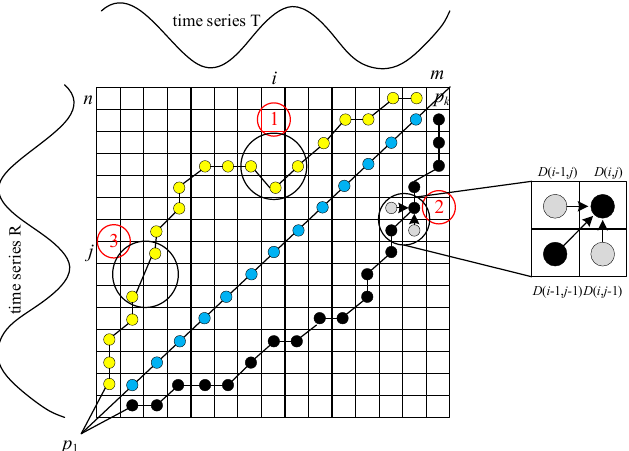
Figure 4. Schematic diagram of DTW constraint path.